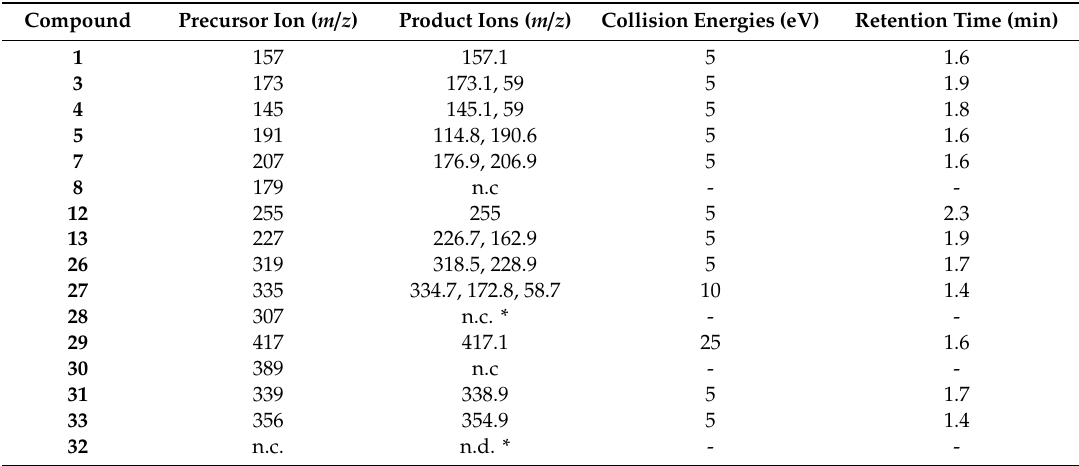
Table 2. Precursor ions and Product ions of tested compounds in product ion scan